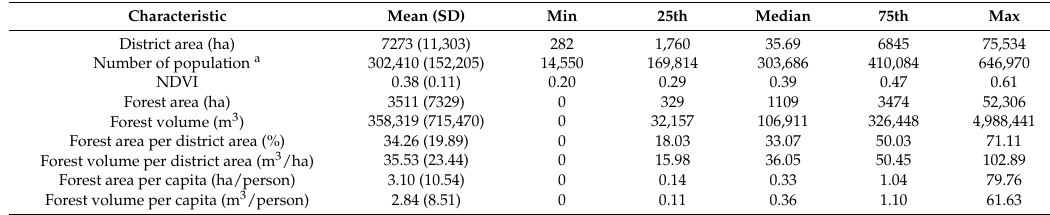
Table 2. Characteristics of the districts ( N =